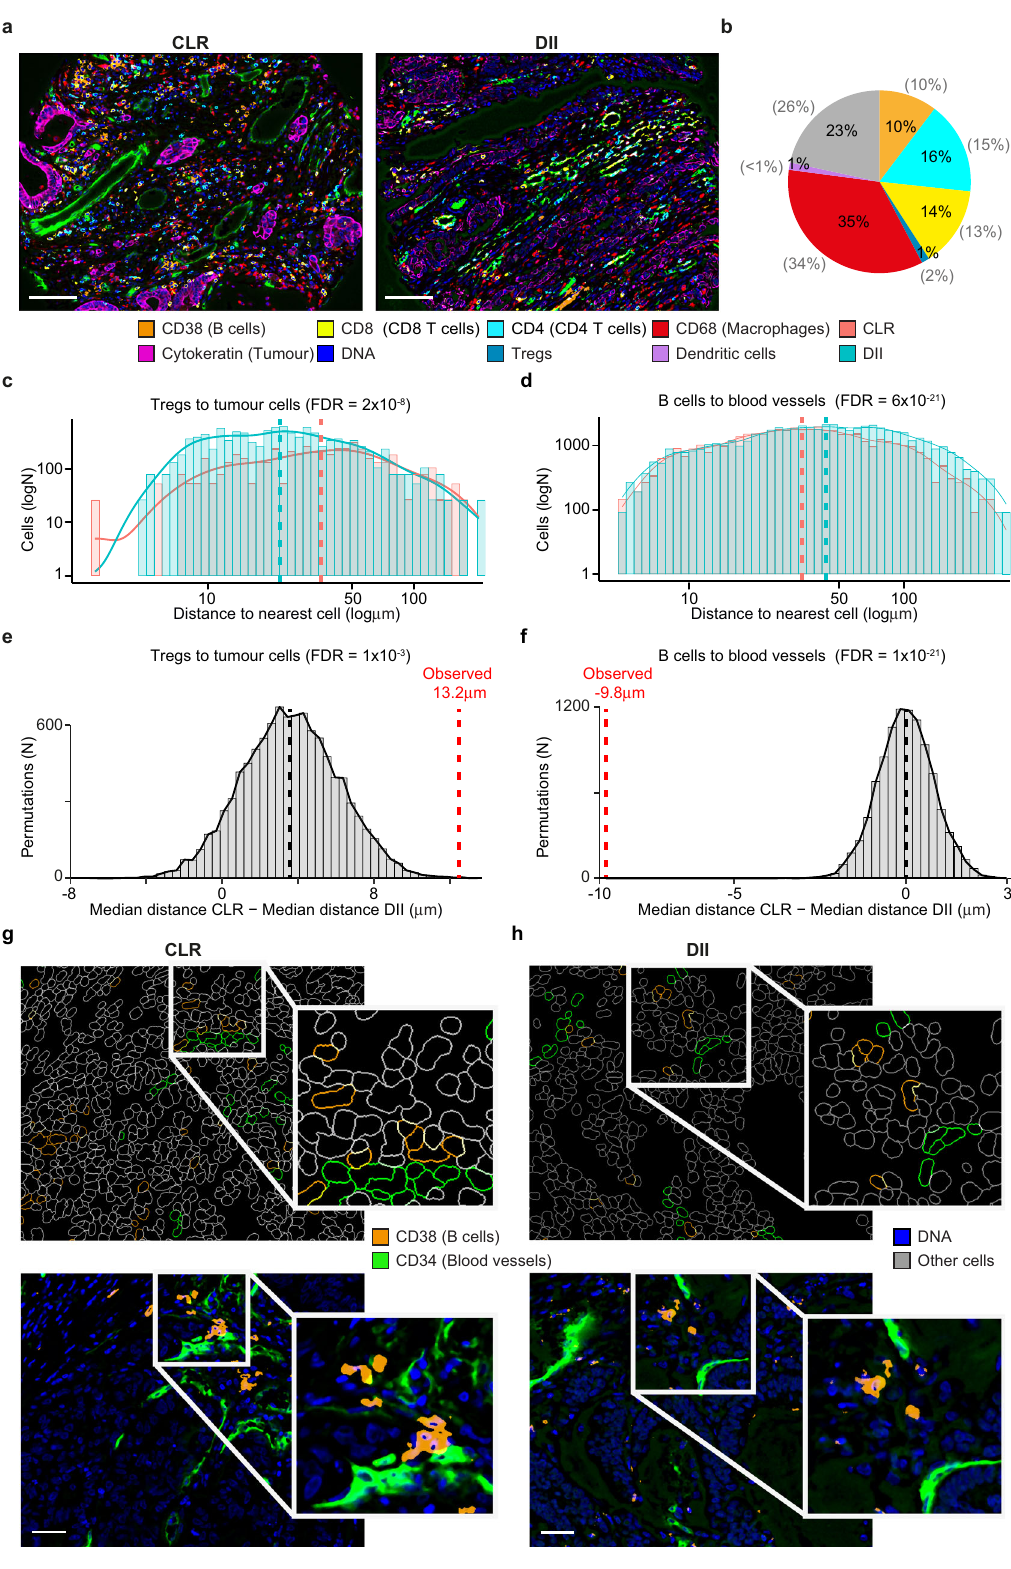
To evaluate the effect of normalisation on the downstream analysis, sample- speci fi c thresholds were manually selected for IgA, E-Cadherin, Pan-Keratin and Vimentin and applied to the raw images. The resulting thresholded images were used to generate lamina propria and epithelial masks for each sample individually. Pixel-level analysis was performed on the IgA masks derived from either the normalised or the raw images and IgA + areas in the tissue, lamina propria and epithelium were measured and normalised over the areas of the three